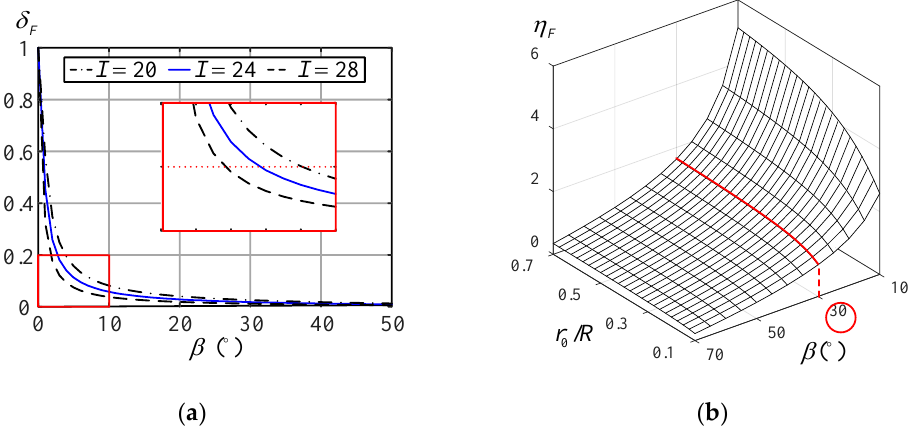
Figure 17. Influence of the dimensional parameters. ( a ) Variation in δ F versus β and I ; ( b ) Variation in η F versus r 0 / R and β .